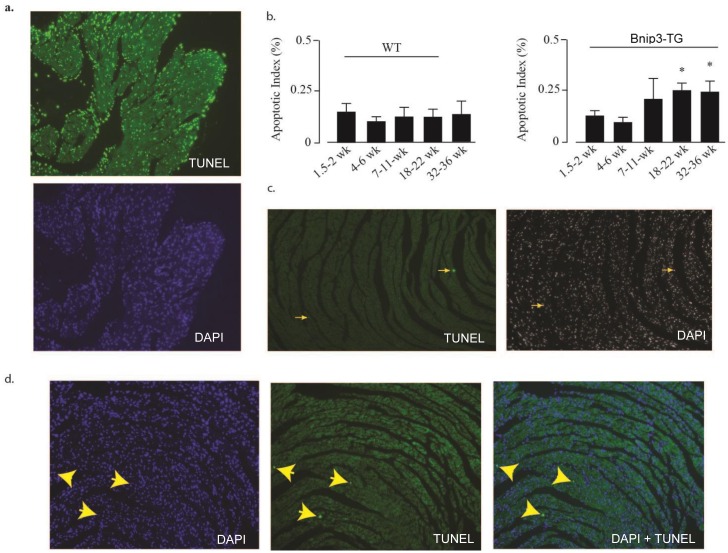
Apoptosis in aged but not young Bnip3-TG mice.TUNEL staining was implemented as described in Methods. (A) The sensitivity of the TUNEL assay was demonstrated by treating heart sections with DNAase I to induce TUNEL positive DNA strain breaks; top panel TUNEL, bottom panel DAPI; >80% of nuclei are TUNEL-positive (data not shown). (B) Apoptotic indices of wild type (WT) and Bnip3-TG mice were determined by TUNEL at the indicated times as described in Methods. Examples of TUNEL staining in heart sections from 5-week old wild type (C) and Bnip3-TG mice (D). Nuclei were co-stained with DAPI. Yellow arrows point to TUNEL positive nuclei and the corresponding DAPI stained nuclei. Results in (B) are mean ± S.E.M.; * p < 0.05, comparing apoptotic indices with 4–6 weeks (n = 5).